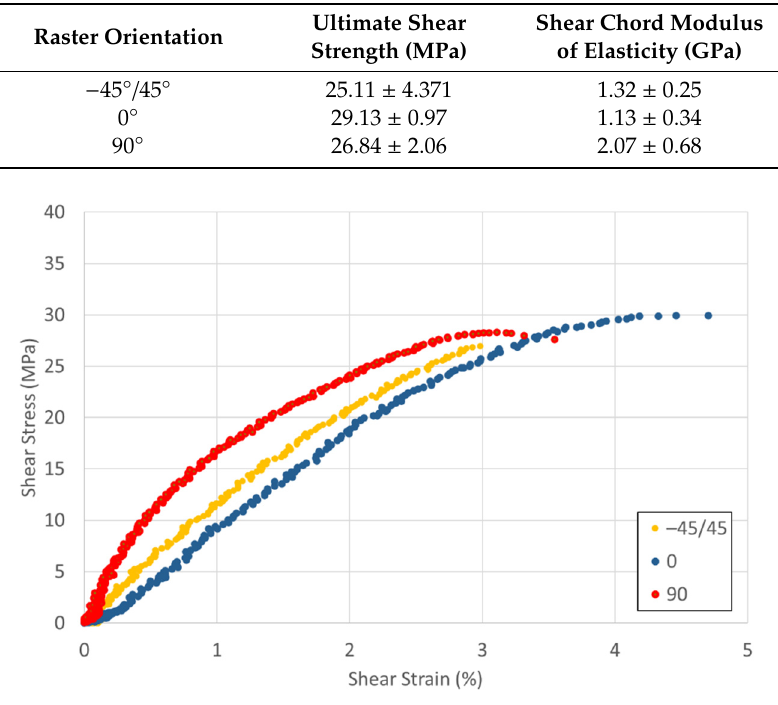
Figure 10. Representative Shear Stress-Strain Curves.